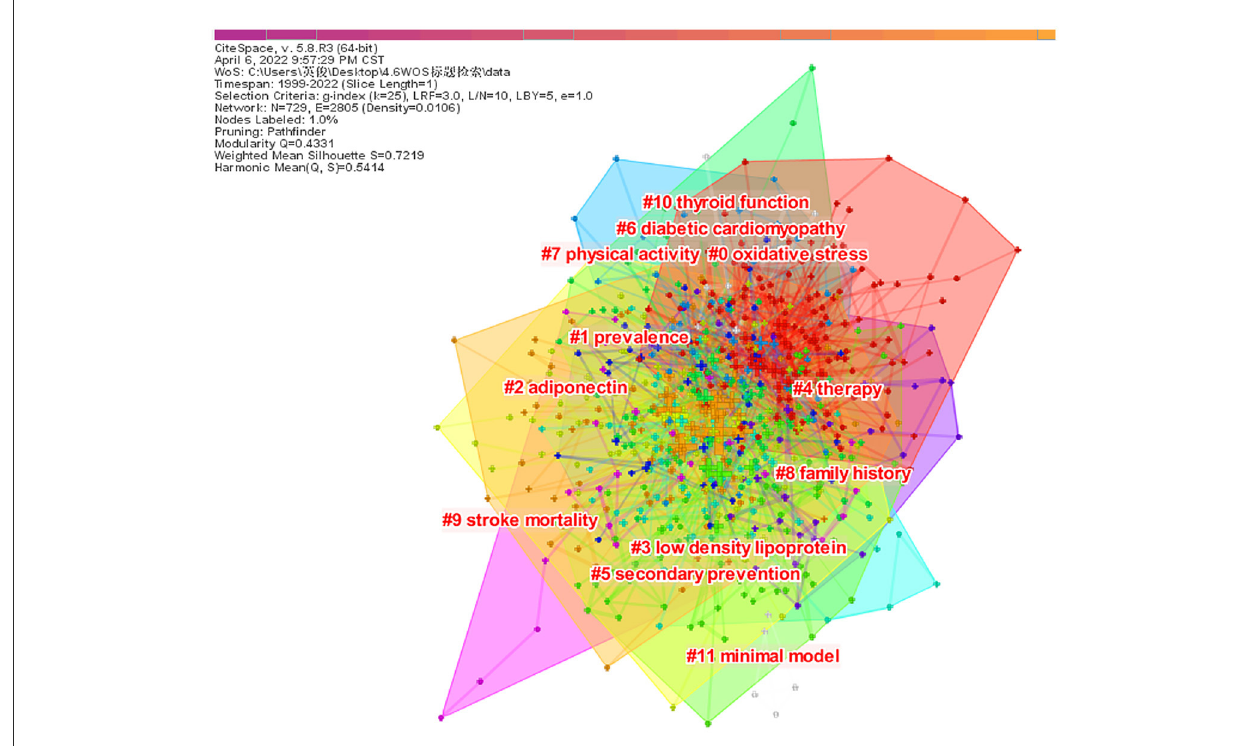
FIGURE6 Keywords cluster analysis co-occurrence map.